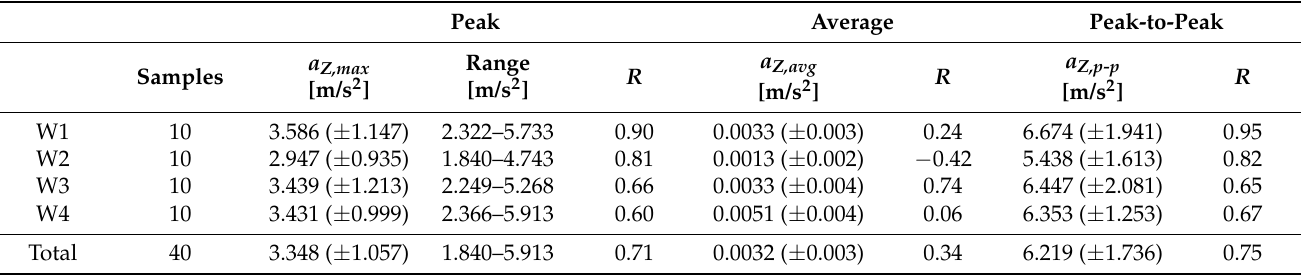
Table 3. Analysis of W1-to-W4 vertical acceleration data (SLAB#1), with standard deviation in brackets and correlation coefficient R